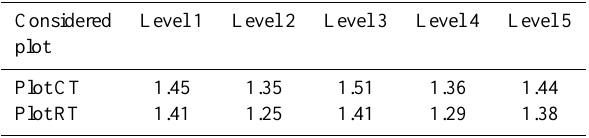
Table 6. Experimental values of the remainder, δ .